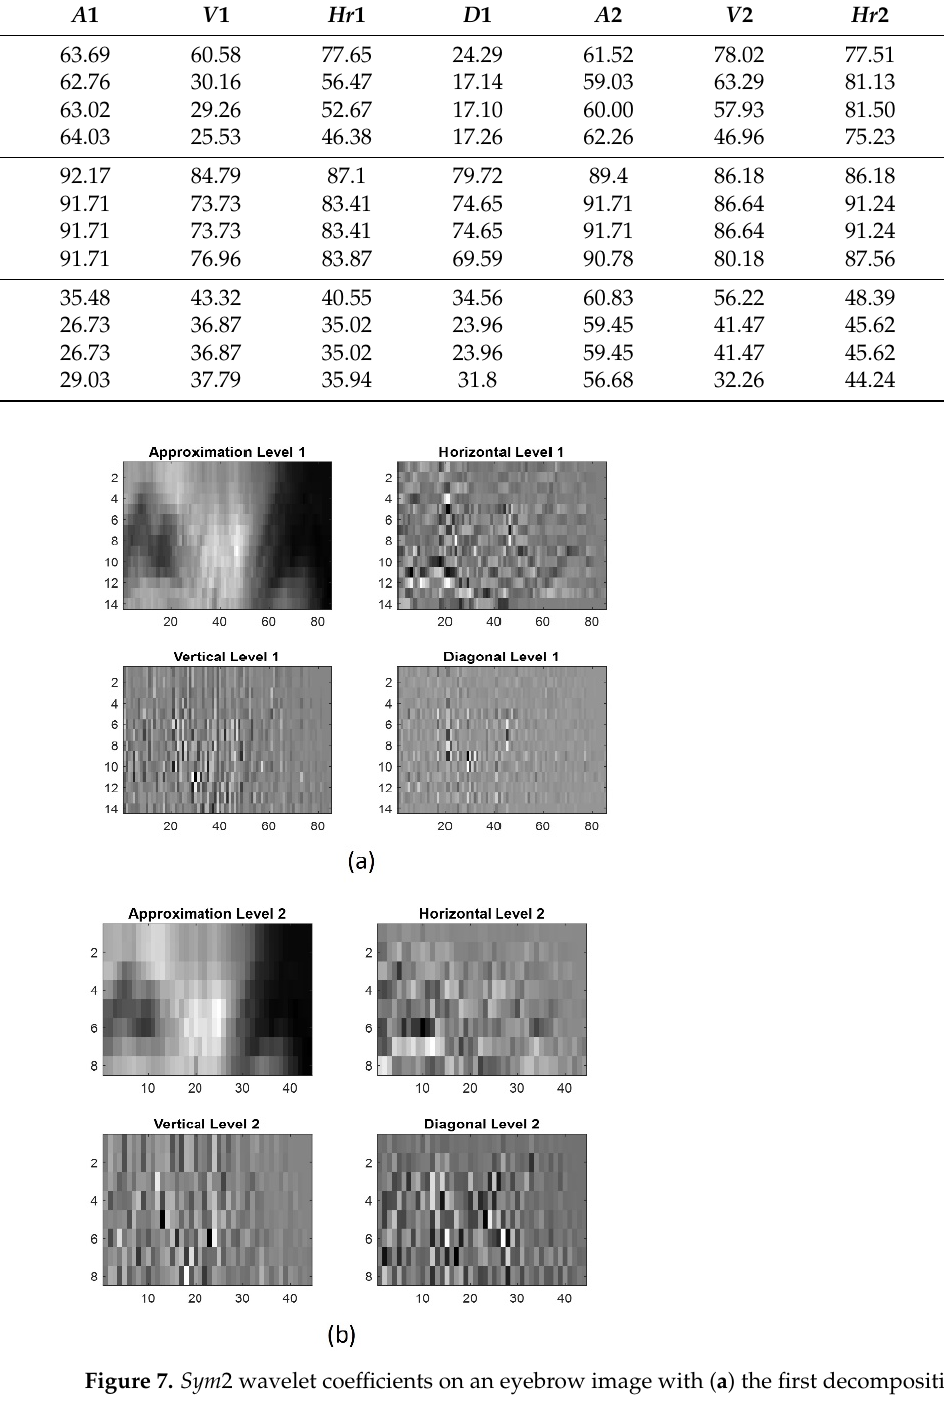
Table 9. The accuracy (%) results of the DWT on the EYB dataset for the eyebrow images. The per- formance was calculated for all wavelet coefficients in two decomposition levels, producing A 1, V 1, Hr 1, D 1, A 1, V 2, Hr 2, and D 2.